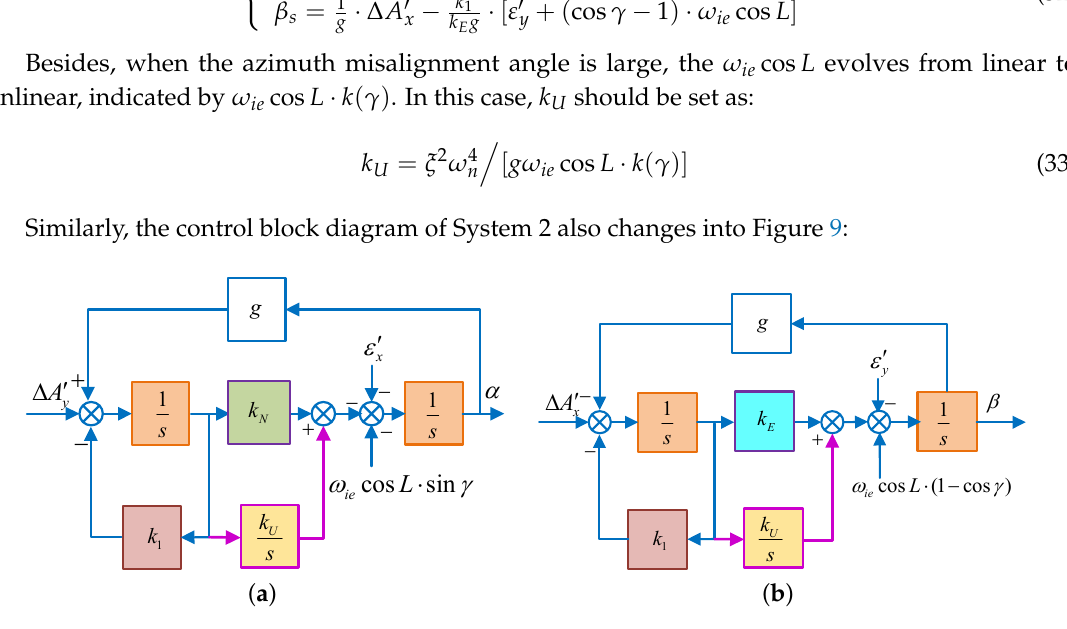
Figure 9. The schematic diagram of horizontal fine alignment in System 2. ( a ) Schematic diagram of horizontal fine alignment in the north loop; ( b ) schematic diagram of horizontal fine alignment in the east